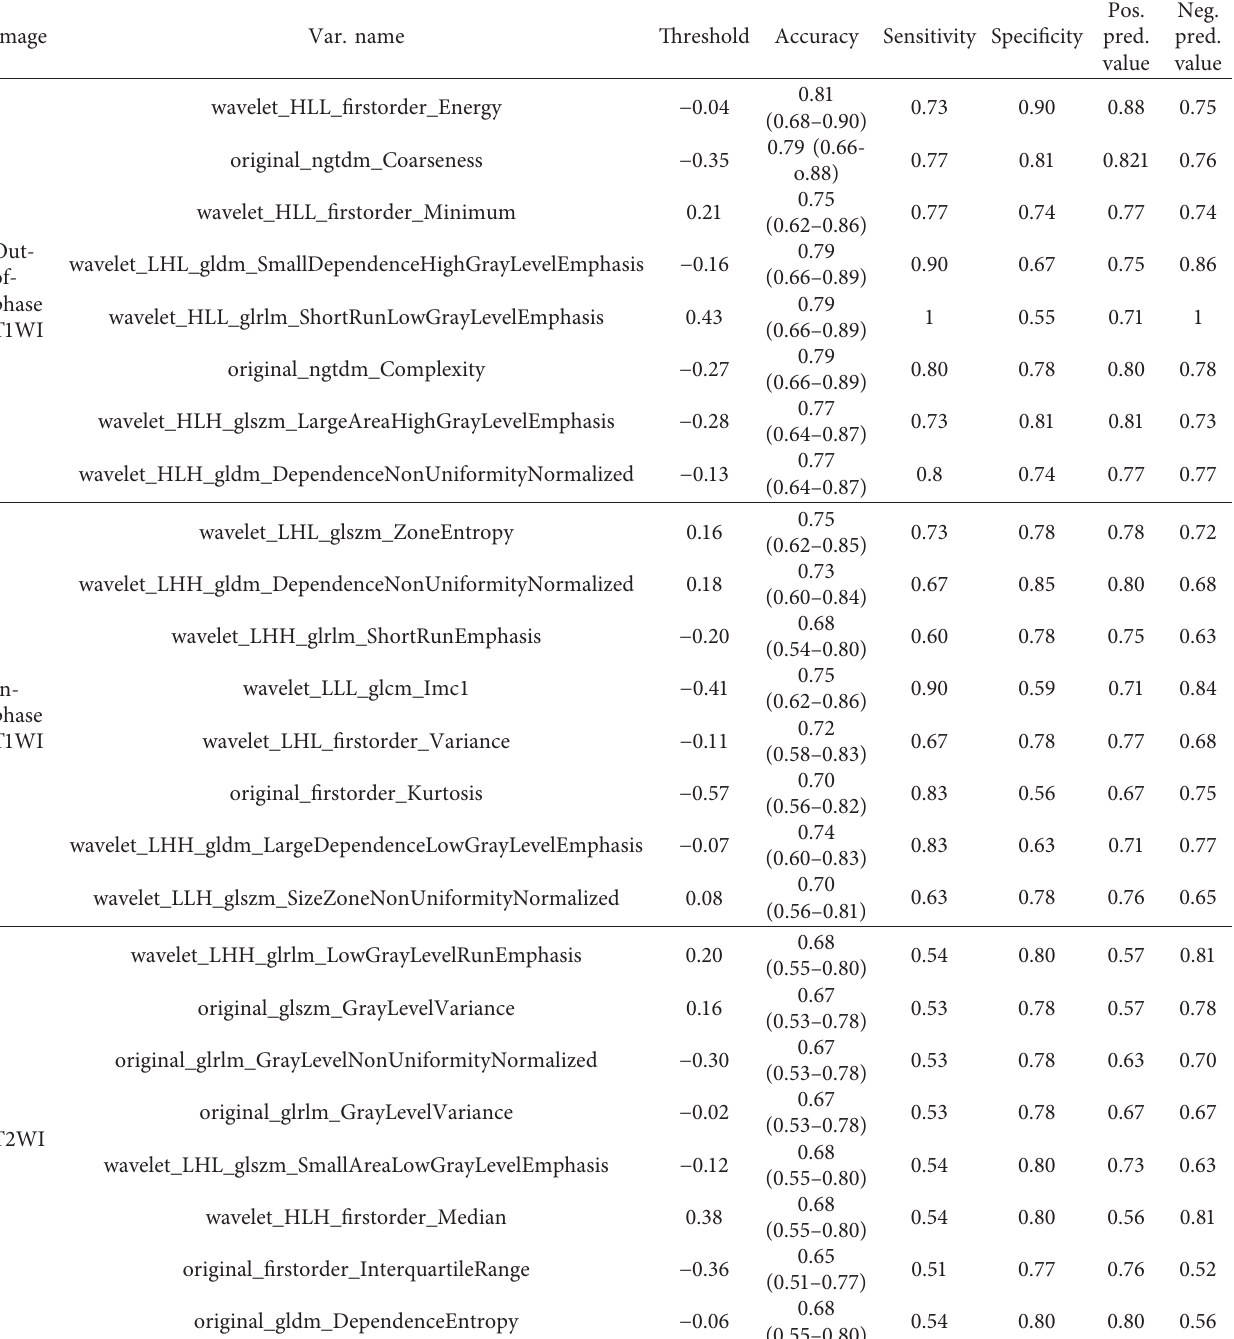
Table 2: Performance of selected features with high